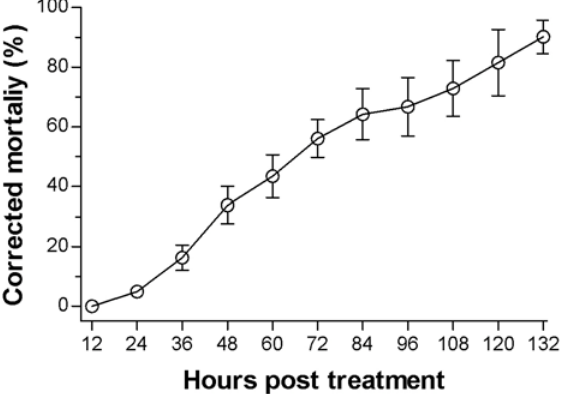
Fig 1. Corrected mortality trend of third-instar P . xylostella larvae infected by B . bassiana . Error bars: SD of the mean from three replicates.